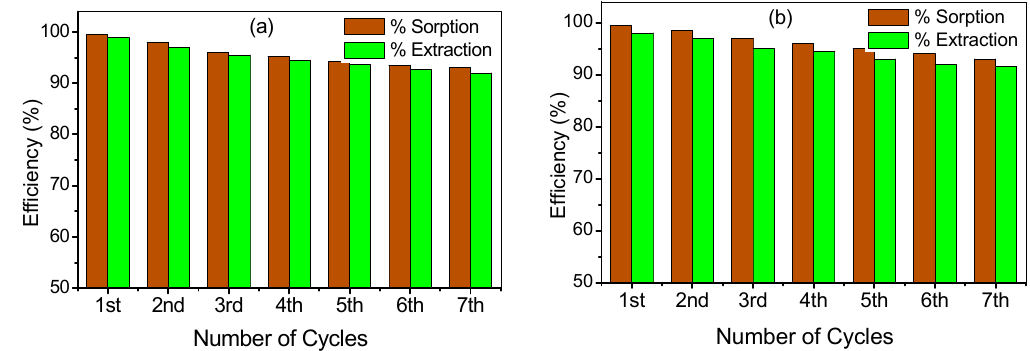
Figure 15. Reusability studies of the poly(hydroxamic acid) ligand ( a ) and poly(amidoxime) ligand ( b ) in 7 cycles of sorption / desorption experiment for copper ions.